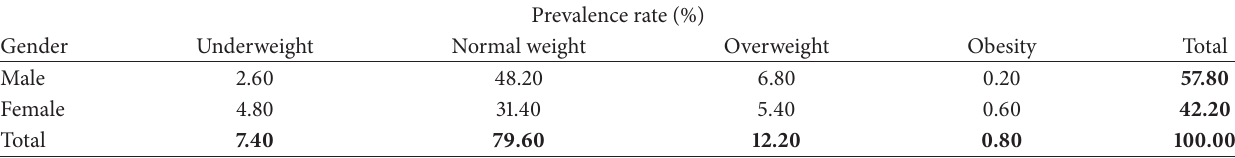
Table 2: Prevalence of underweight, normal weight, overweight, and obesity according to